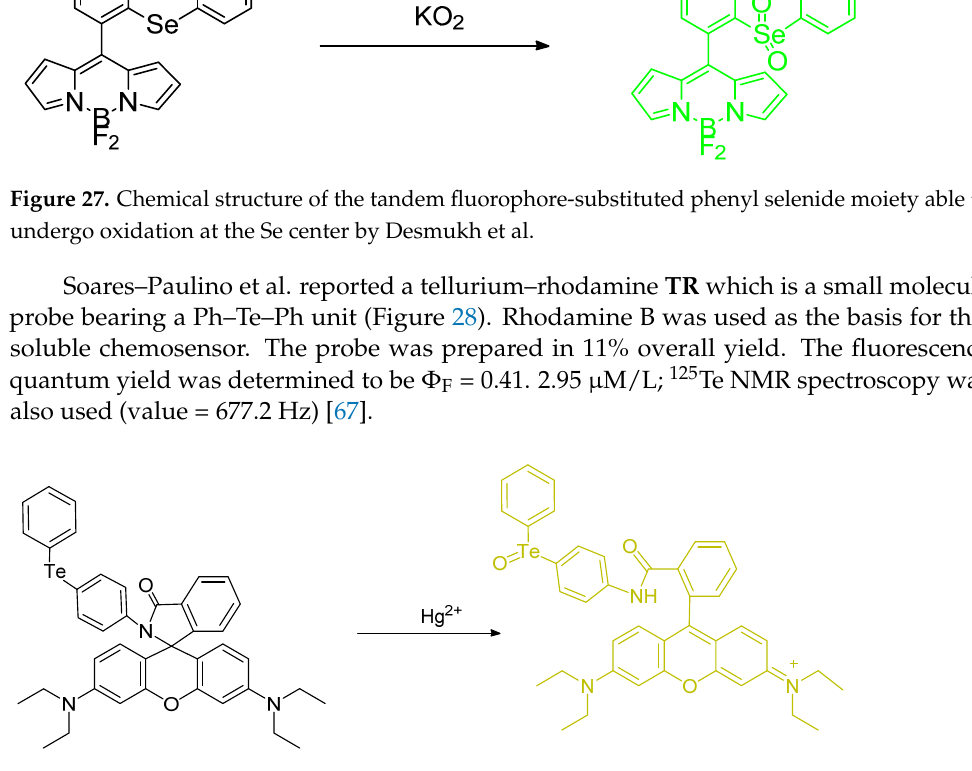
Figure 28. Rhodamine–based phenyl telluride–substituted system used for mercuric detection by Soares–Paulino et al.